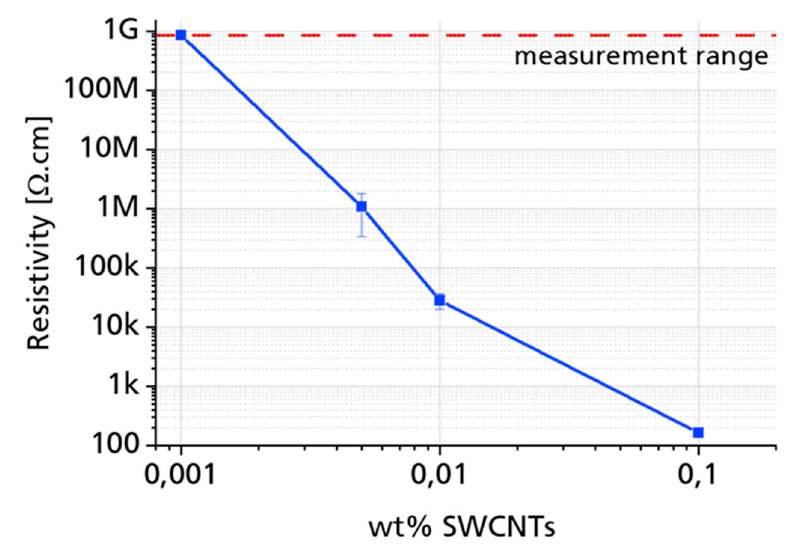
Figure 4. Through-plane electrical resistivity of SWCNT/epoxy as a function of particle concentration for eight passes.